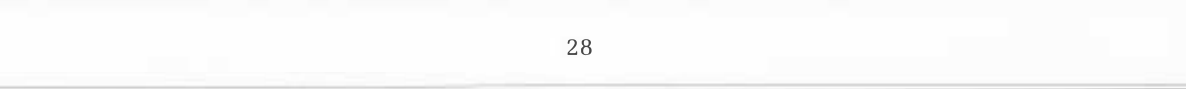
Figure 1 Southwestern Turkmenistan and northeastern Iran showing the location ofmesolithic and neolithic {Jeitun Culture) sites; only those sites mentioned in the text are